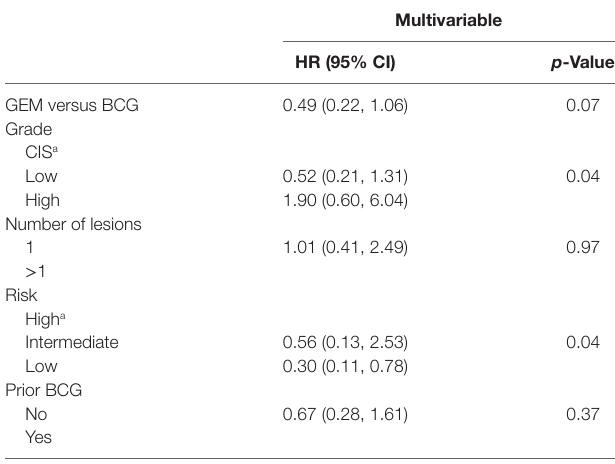
TaBle 2 | Cox proportional hazard